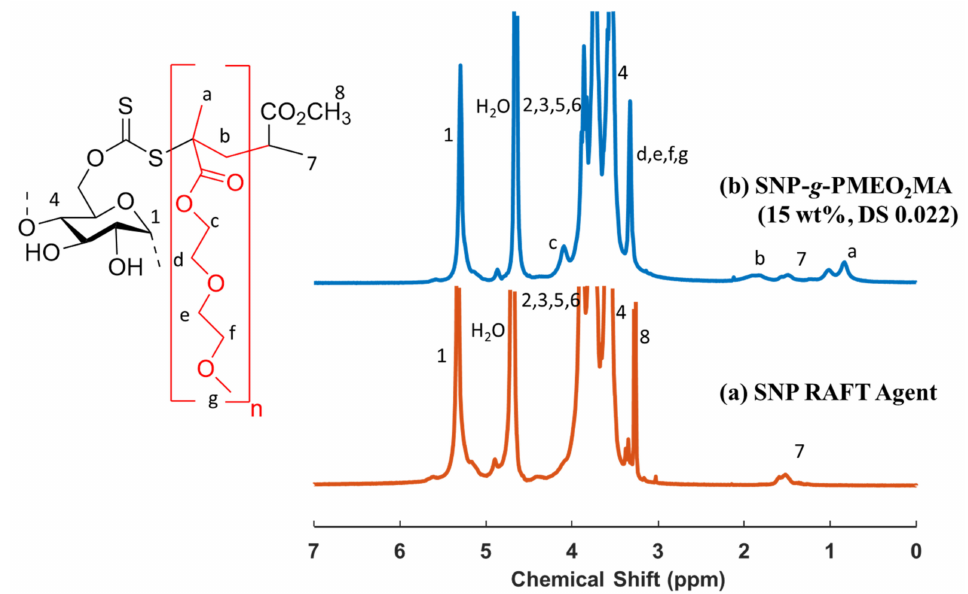
Figure 1. 1 H NMR spectra in D 2 O at 25 ◦ C for ( a ) starch-based RAFT agent, ( b ) SNP- g -PMEO 2 MA (15%, DS 0.022). The labels in the spectra identify the different types of protons in the structure on the